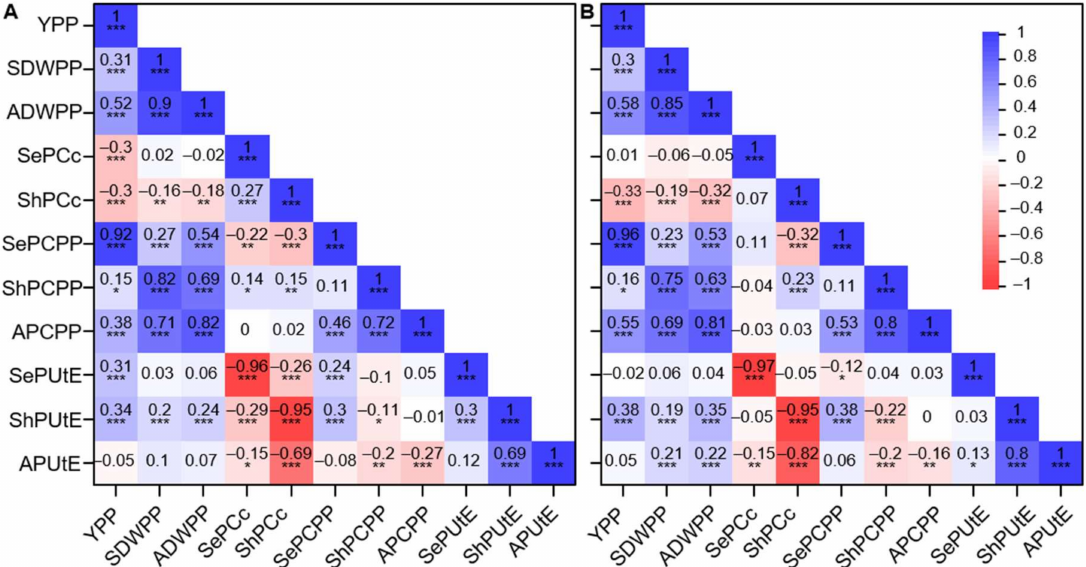
Figure 2. Correlations among eleven traits under low-P ( A ) and normal-P ( B ) conditions. YPP: Yield per plant; SDWPP: Shoot dry weight per plant; ADWPP: All dry weight per plant; SePCc: Seed P concentration; ShPCc: Shoot P concentration; SePCPP: Seed P content per plant; ShPCPP: Shoot P content per plant; APCPP: P content per plant; SePUtE: Seed P